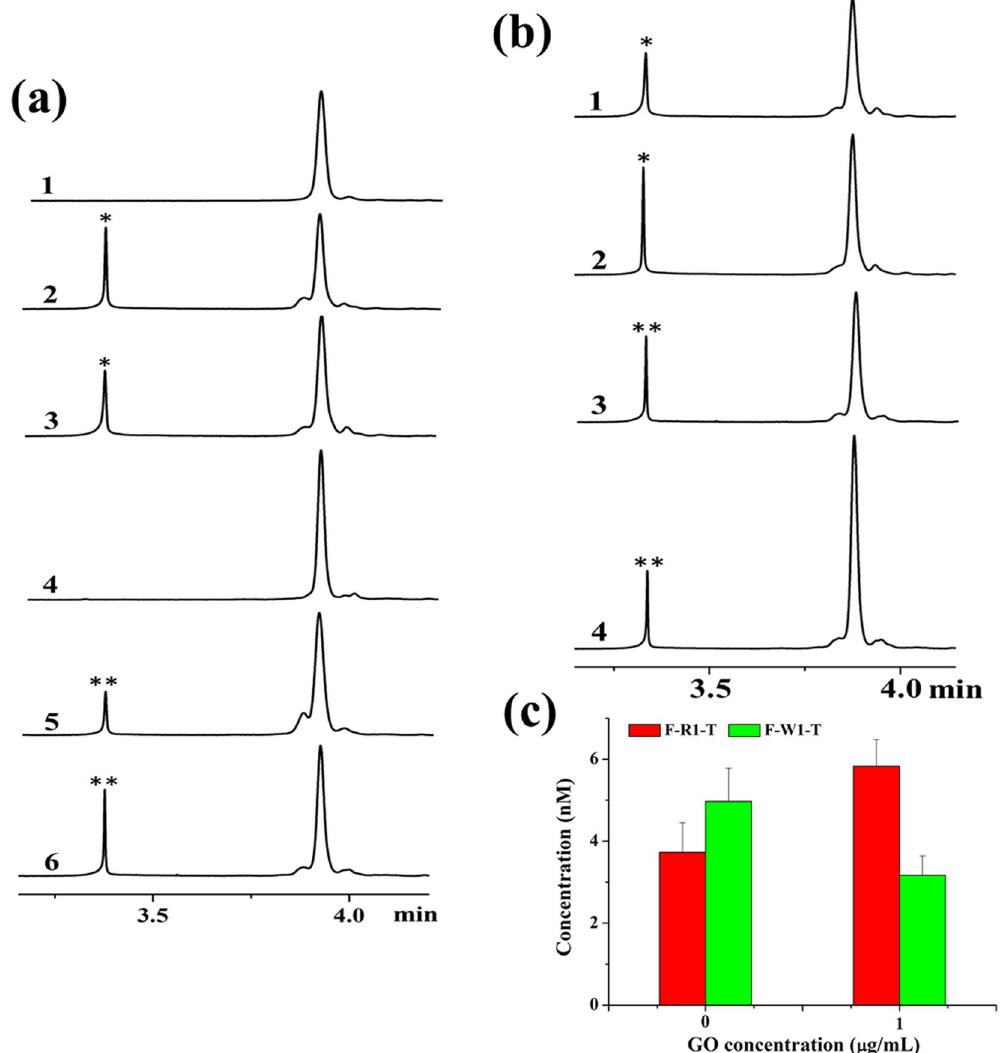
Figure 5. ( a ) CE-LIFP analysis of the interaction of F-R1 and F-W1 with template and polymerase. Reaction solutions contained 1: F-R1; 2: F-R1 and template; 3: F-R1, template, and polymerase; 4: F-W1; 5: F-W1 and template; 6: F-W1, template, and polymerase. ( b ) CE-LIFP analysis of complex conformation in the presence of GO. Reaction solutions contained 1: F-R1, template, and polymerase; 2: F-R1, template, polymerase, and GO; 3: F-W1, template, and polymerase; 4: F-W1, template, polymerase, and GO. ( c ) Change of F-R1-template and F-W1-template complex concentrations in the presence of GO. The concentrations of primers (F-R1 and F-W1), template, and polymerase are 10 nM, 10 nM, and 0.5 U, and the concentration of GO is 1 μ g/mL. All reaction solutions were run with a cycle of 45 s at 95 °C, 1 min at 50 °C, and 1 min extension at 72 °C before CE-LIFP